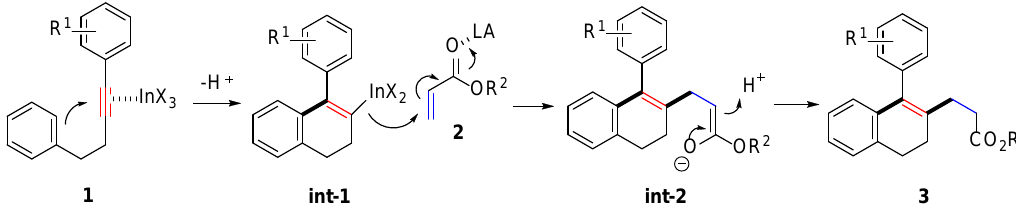
Table 1. The In(III)-TMSBr-catalyzed cascade reaction of diarylalkyne 1a with methyl acrylate ( 2a ) a .